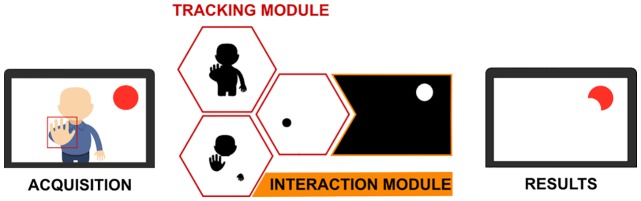
Interaction module.